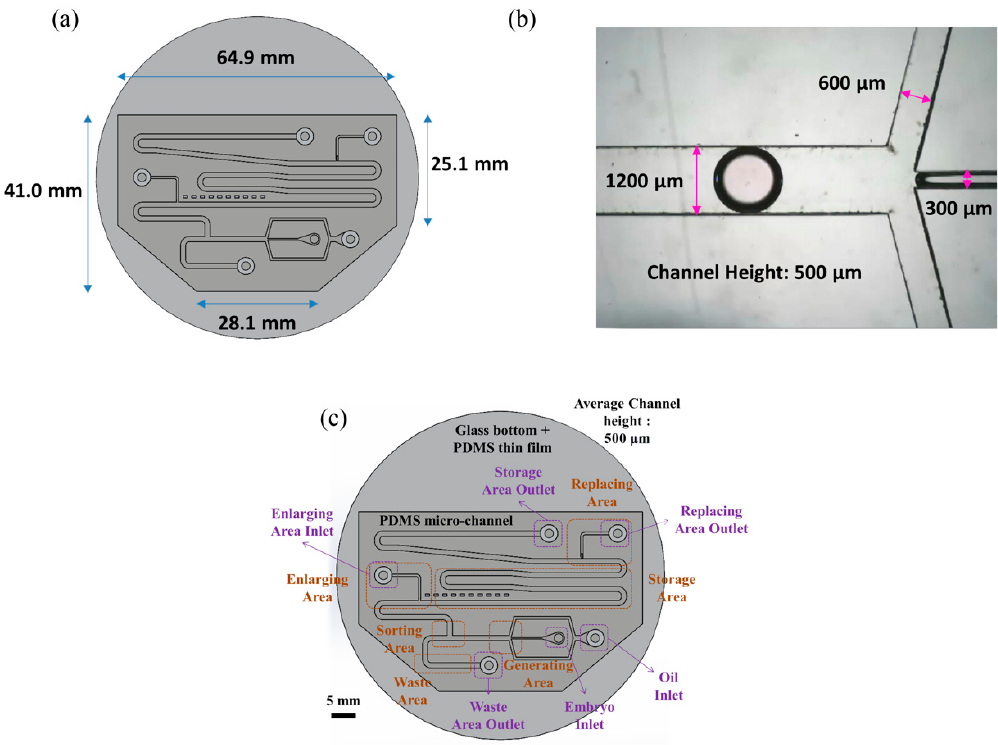
Figure 1. ( a ) The shape of the chip is hexagonal. The length of the longest side is 64.9 mm; the longest base length is 28.1 mm. ( b ) The width of our main channel is 1200 µ m; the height of the channel is 500 µ m. ( c ) There are six sections and six entrances in the chip.